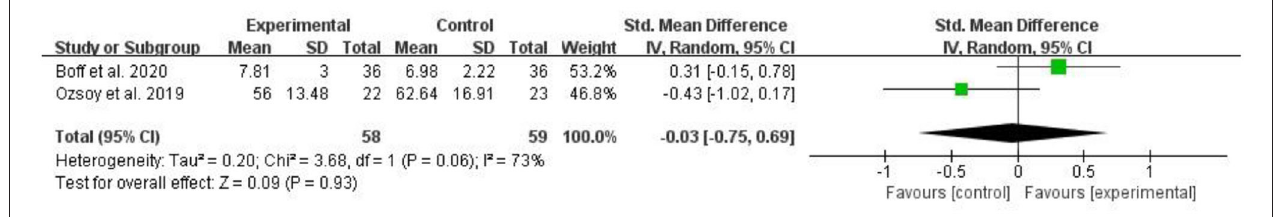
FIGURE 7 | Meta-analysis on pain pressure-threshold.